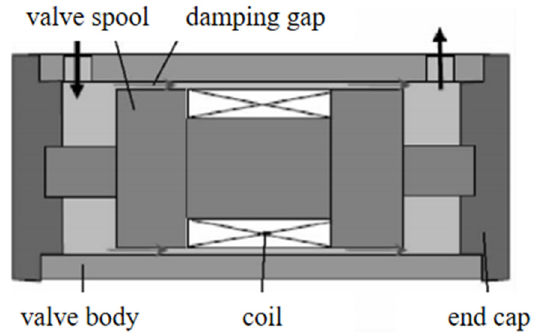
Figure 11. Schematic diagram of a typical MR valve structure [67].